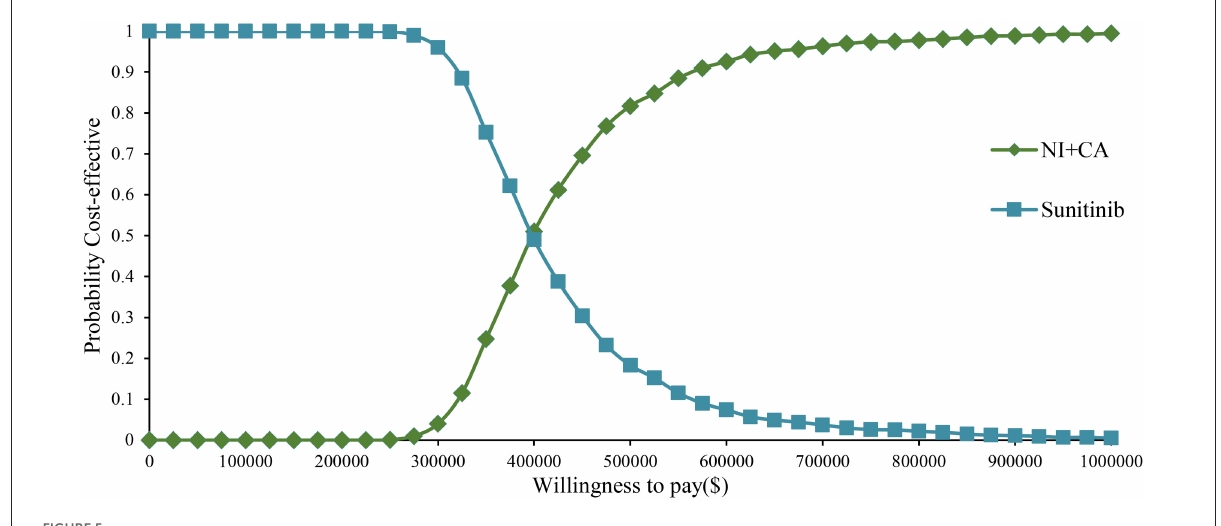
FIGURE5 Cost-effectiveness acceptability curve in the partitioned survival